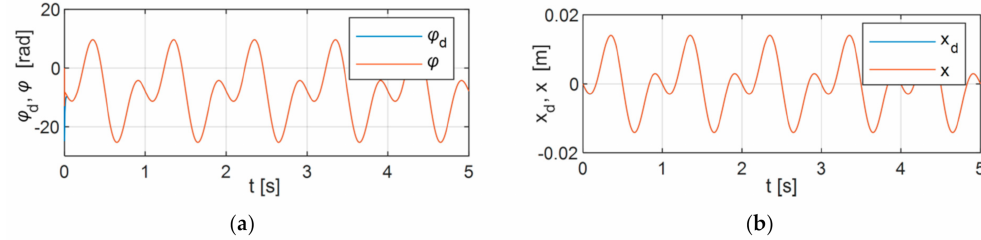
Figure 8. Trajectory: ( a ) adjusted ϕ d and realized ϕ positions of the active part; ( b ) adjusted x d and realized x positions of the passive